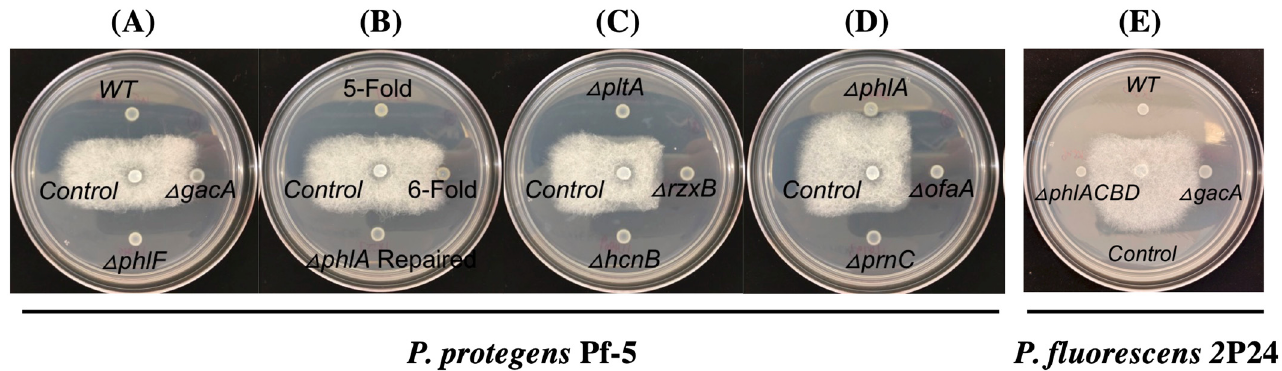
Figure 2. Inhibition of Pf-5 ( A – D ) and 2P24 ( E ) and their derivatives against A. euteiches on plates. A. euteiches was cultured in the center of the plates and the bacterial cells were inoculated around the pathogen. WT: wild type; 5-fold: Pf-5 mutant, ∆ pltA ∆ pcnC ∆ ofaA ∆ rzxB ∆ hcnB ; 6-fold: Pf-5 mutant, ∆ pltA ∆ pcnC ∆ ofaA ∆ rzxB ∆ hcnB ∆ phlA ; control has no bacteria inoculation. All strains were cultured on 1 / 2 PDA plates at 28 ◦ C for two days before the results were recorded. Photos are representatives of three replicates and the experiment was repeated three times with similar results.